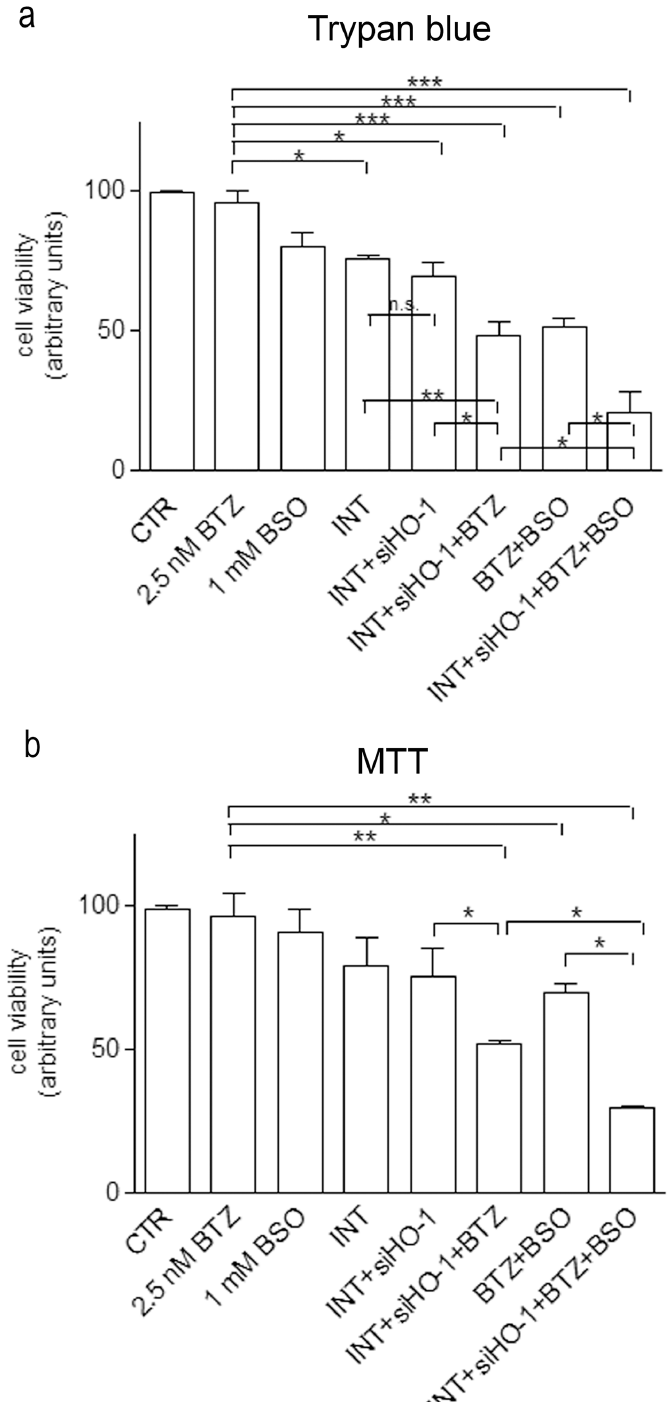
Fig 3. GSH depletion and HO-1 silencing improve the efficacy of BTZ in reducing cell viability. The number of viable cells were detected by Trypan blue dye exclusion test (a) and MTT assay (b). Cells were treated for 24 h with 2.5 nM BTZ, 1 mM BSO or silenced for HO-1, as indicated. Some samples were treated with the siRNA transfection reagent Interferin (INT) alone, as internal control. The graphs show the mean value of three independent experiments (mean ± SE); * p < 0.05; ** p < 0.01; *** p < 0.001; n.s. no significant.